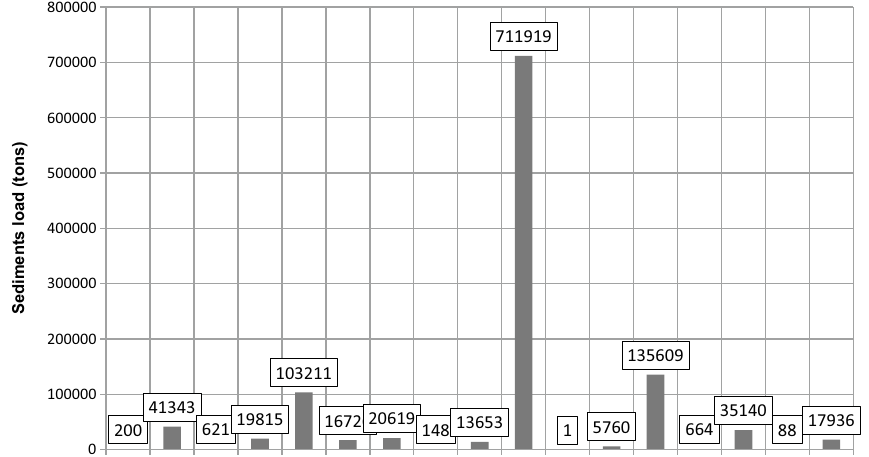
Fig. 9 Yearly sediment inputs to the future dam